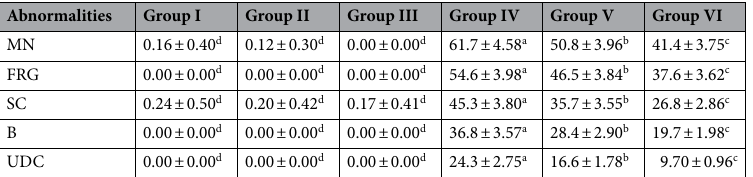
Table 2. Protective role of Bmex against glyphosate-induced genotoxicity. Group I: Control, Group II: 350 mg/L Bmex, Group III: 700 mg/L Bmex, Group IV: 500 mg/L glyphosate, Group V: 500 mg/L glyphosate + 350 mg/L Bmex, Group VI: 500 mg/L glyphosate + 700 mg/L Bmex. Values are shown as mean ± SD ( n = 10 ). 1000 cells in each group were analyzed for MN and CAs. The averages shown with different letters (a–d) in the same line are significant at p < 0.05. MN micronucleus, FRG fragment, SC sticky chromosome, B bridge, UDC unequal distribution of chromatin.